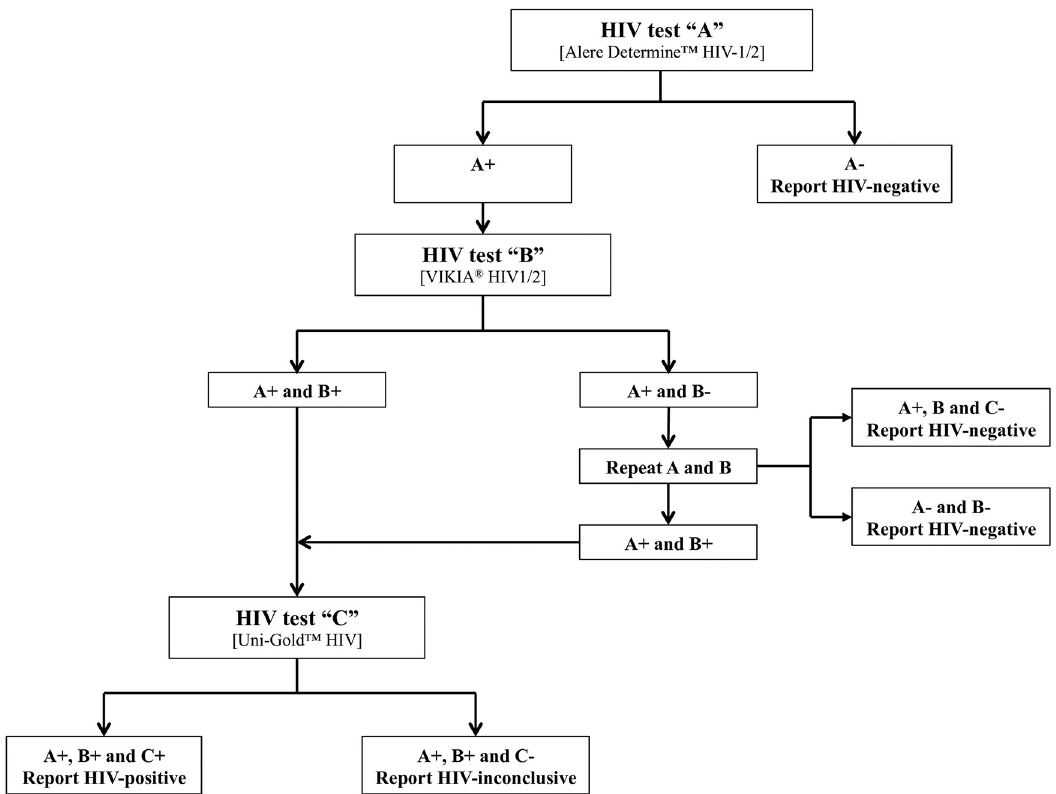
Fig 1. Flow-chart showing the national algorithm of HIV testing in the Democratic Republic of the Congo [12]. Alere Determine HIV-1/2 (Alere, Chiba-ken, Japan), VIKIA HIV1/2 (bioMe´rieux, Lyon, France), and Uni-Gold HIV (Trinity Biotech, Wicklow, Ireland) were used as the first, second, and third test,